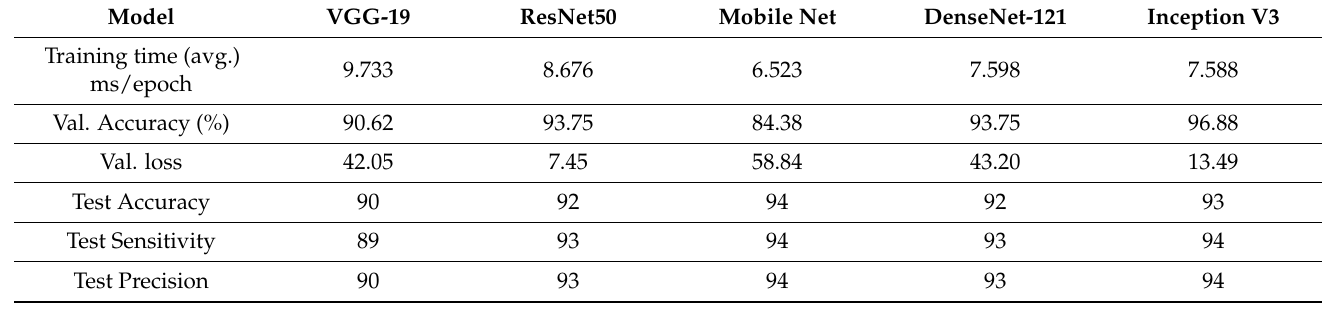
Table 3. Comparison of pre-trained models for 2 Class Classification.